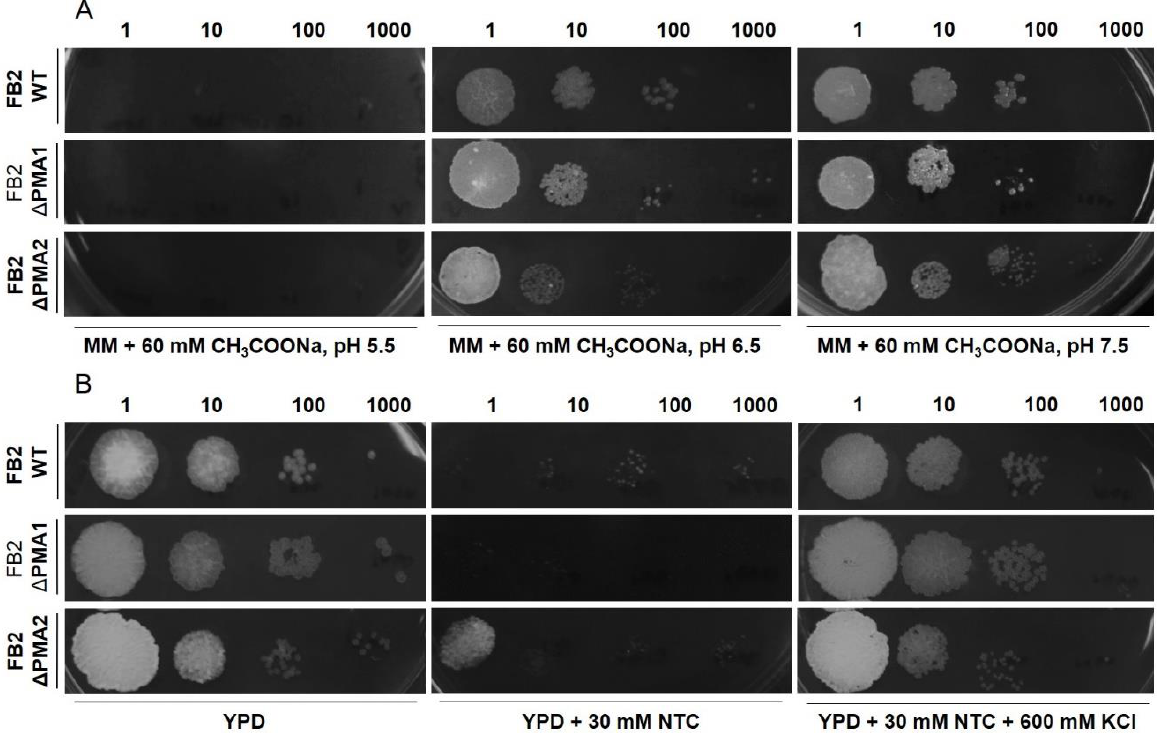
Figure 4. Effect of acetate, nourseothricin, and KCl on cell growth. U. maydis wild-type and mutant strains were grown in MM or YPD media to determine the effect of CH 3 COOH ( A ) or NTC ( B ) with or without KCl; NTC: Nourseothricin.